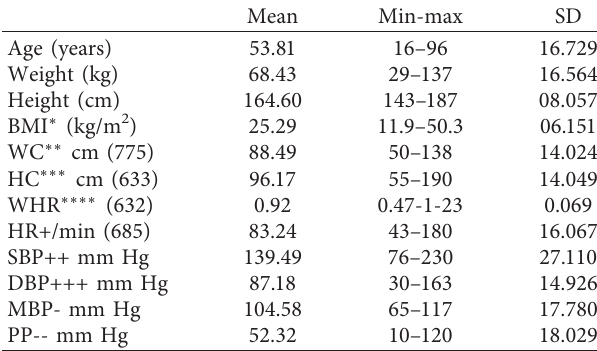
Table 2: Means for anthropometric and pressure values in the sample of 793 patients in the CVR assessment